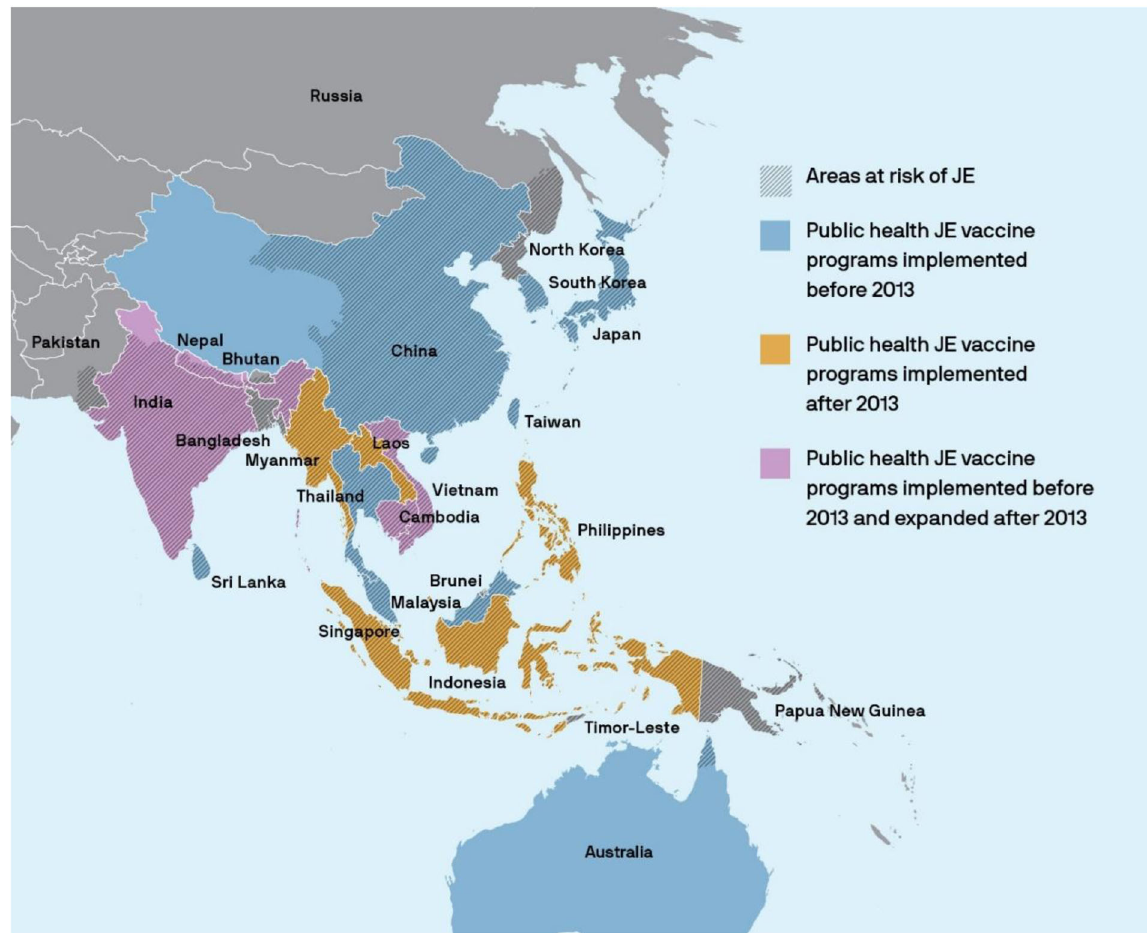
Fig. 1 Areas with risk of Japanese encephalitis (JE) transmission and JE vaccine introduction relative to the WHO JE vaccine prequali fi cation year (2013). While some countries have implemented national public health JE vaccine programs, others may have only introduced in high risk